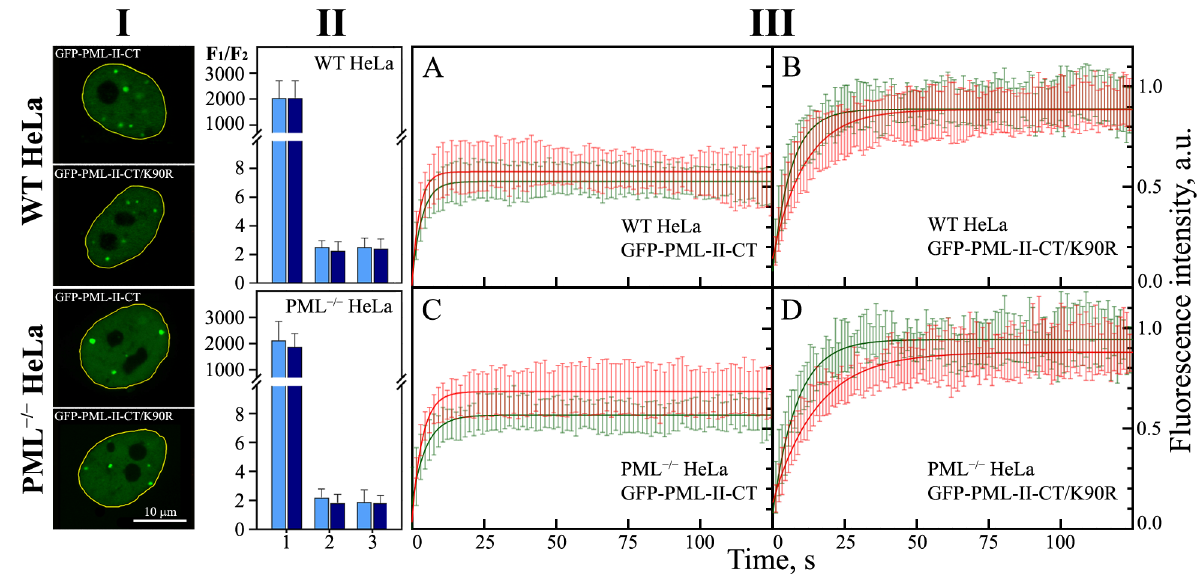
Figure 3. Localization, shape, and dynamic properties of the condensates formed by the C-terminal domain of PML-II isoform (PML-II-CT) and its mutant form with the K490R amino acid replacement (PML-II-CT/K490R) in wild-type HeLa cells (WT HeLa) and PML knockout HeLa cells (PML − / − HeLa). Panel ( I ): Nuclear localization of condensates formed by PML-II-CT and PML-II-CT/K490R in the WTHeLa and PML − / − HeLa. Panel ( II ): Relative contents of the isoform PML-II, PML-II-CT and PML-II-CT/K490R in bodies formed by these proteins and the nucleoplasm in the WT HeLa (upper panel), and the PML − / − HeLa (lower panel) are shown by bars 1, 2 and 3, respectively. Light blue bars correspond to the normal conditions and that dark blue bars to H 2 O 2 -treated cells. The concentration of exogenously expressed forms of PML was estimated by the ratio of the average fluorescence intensity observed in the bodies (F1) to the average fluorescence intensity in a region of the same size in the nucleoplasm (F2). Bars and error bars represent means and s.d. ( n = 3). Panel ( III ): Curves of EGFP fluorescence recovery after photobleaching of PML-II-CT (panels ( A , C )) and PML-II-CT/K490R (panels ( B , D )) in the WT HeLa (panels ( A , B )) and the PML − / − HeLa cells (panels ( C , D )). The curves of the photoreduction of the target proteins at the normal conditions are shown in red, and the stress conditions (H 2 O 2 ) are shown in green. Solid curves represent the fit of the FRAP data in the framework of the mono-exponential approximation. The standard deviations of the data are shown by the error bars of the corresponding color.